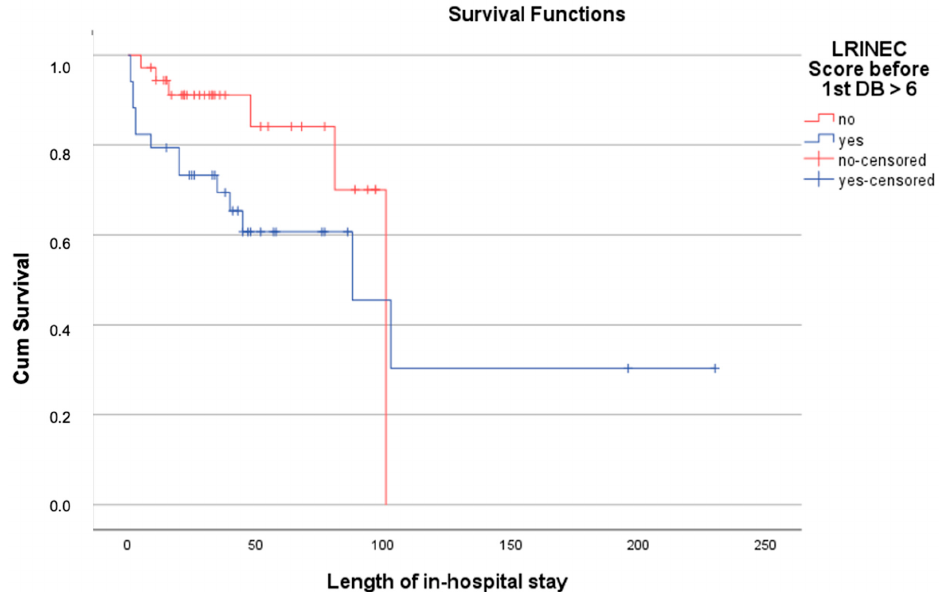
Figure 4 . Survival analysis for hospital survival of patients with